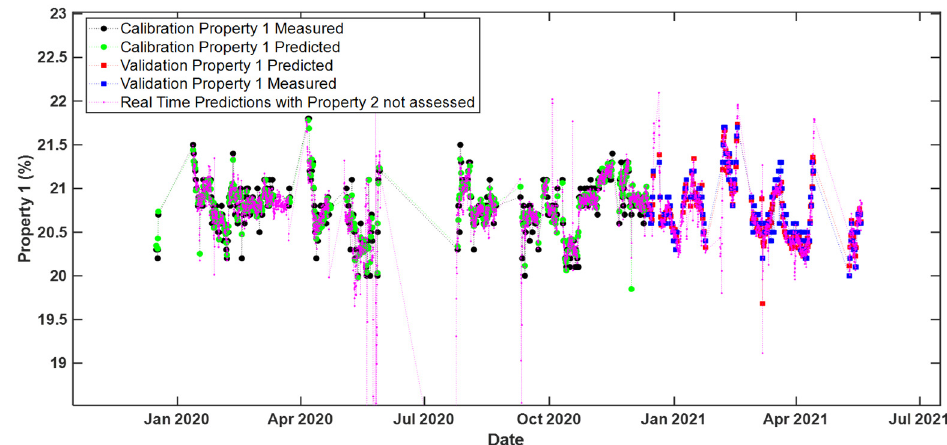
Figure 7. Real time predictions of Property 1 (i.e., time evolution of the measured and predicted values). The predictions were obtained by means of the ‘ROSA all’ model. Legend: black circles—calibration set measured values; green circles—calibration set predicted values; blue squares—validation set measured values; red squares—validation set predicted values; magenta dots—predicted values related to time points for which no reference response measurements were available. For ease of visualization only every 2 h predictions during the considered time period are shown.